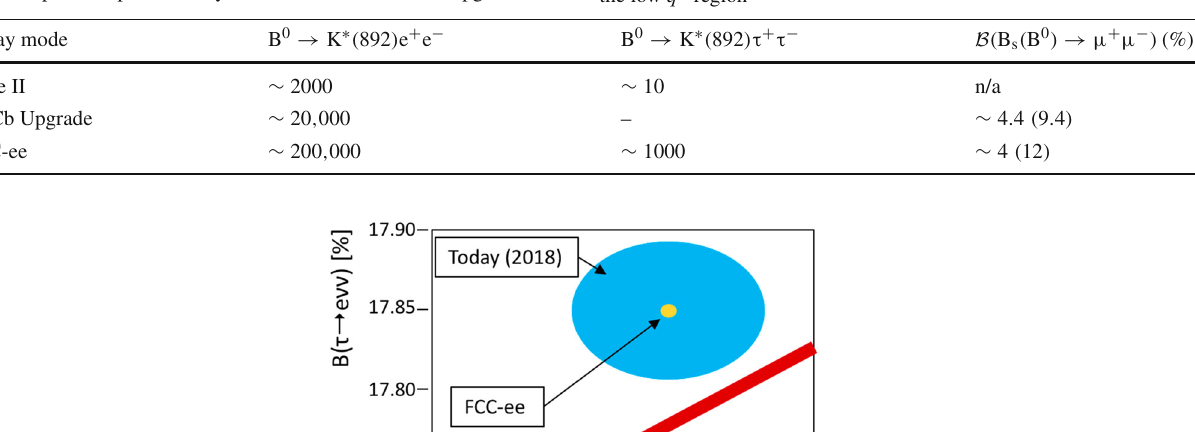
Fig. 7.1 Invariant mass reconstruction of ¯ B 0 → K ∗ 0 ( 892 ) τ + τ − candidates (green line), where τ → 3 πν τ and K ∗ → K + π − , allowing the decay vertices to be reconstructed. The two dominant backgrounds are included: ¯ B s → D + s D − s K ∗ 0 ( 892 ) (red) and ¯ B 0 → D + s ¯ K Table 7.2 Comparison of orders of magnitude for expected recon- structed yields or branching fractions of a selection of electroweak pen- guin and pure dileptonic decay modes in Belle II, LHCb upgrade and